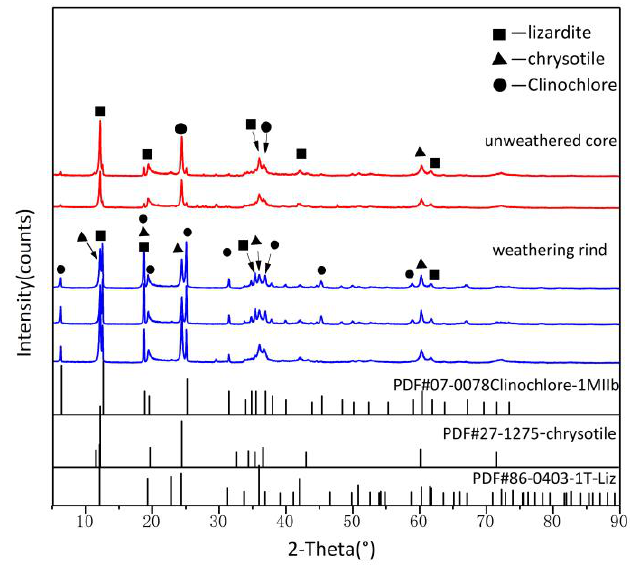
Figure 4. The XRD patterns of weathering rinds and unweathered cores. Table 2. Lattice parameters of weathering rinds and unweathered cores.